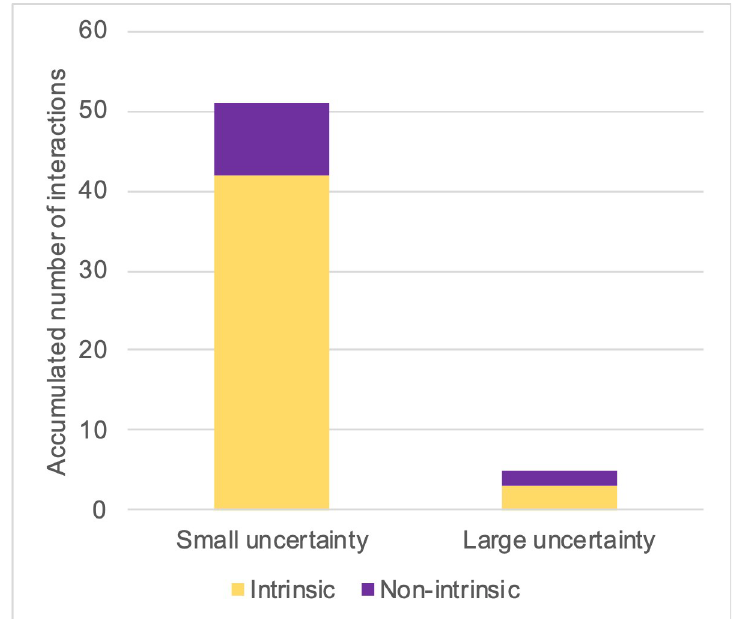
Fig 18. Accumulated number of interactions by motivation type.